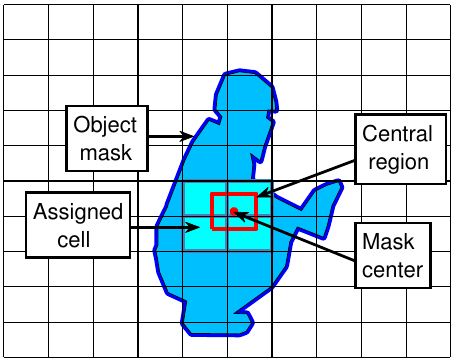
Figure 5. Cells assigned to detect an object. The blue contour marks the object mask. The red dot marks the center of the object mask. The red rectangle marks the center region. The cyan areas mark the cells assigned to detect the object.